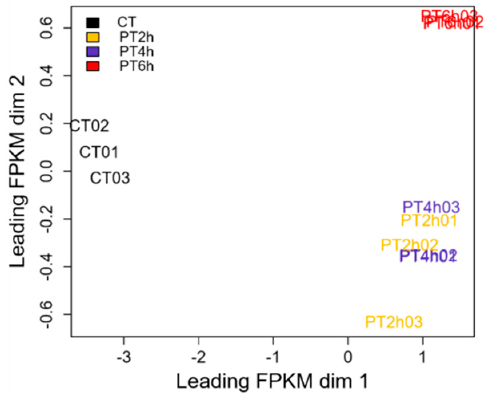
Figure 2. Multidimensional scaling plot of common differentially expressed genes (cDEGs). This figure shows expression pattern of gene set and data quality of cDEGs expressed in each experimental group.